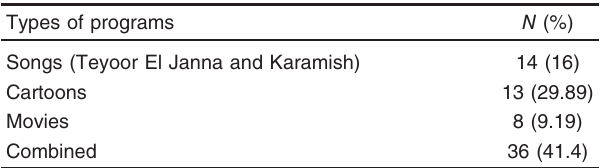
Table 1 Number and percentages of children watching different types of television programs Types of